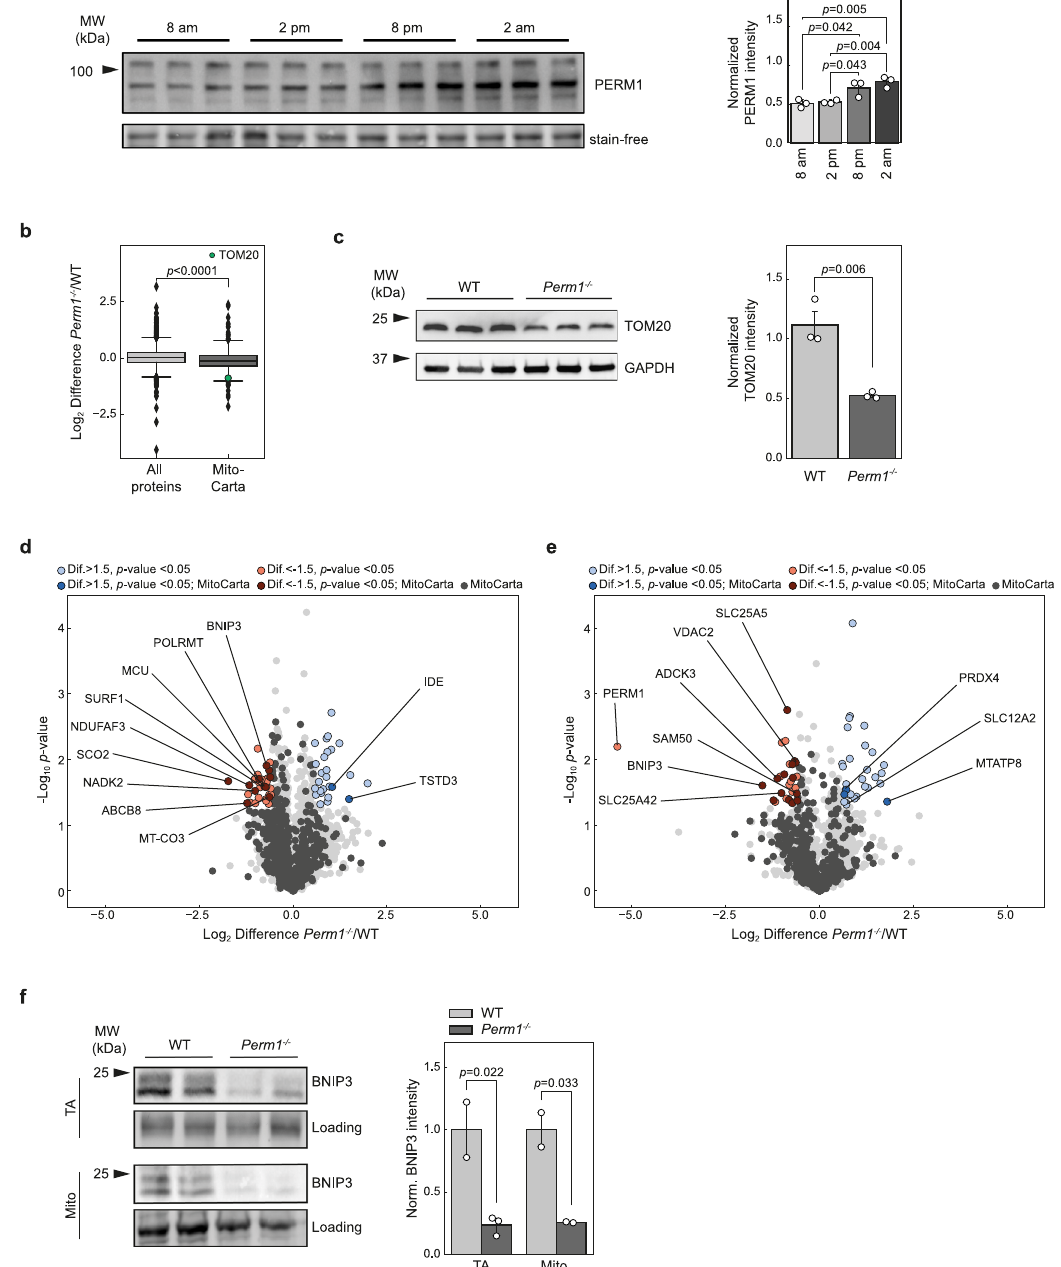
Fig. 3 Inactivation of Perm1 affects mitochondrial proteins related to transportation and breakdown of ROS. a Protein levels of PERM1 at different timepoints in TA muscle determined by western blotting. Normalized protein levels are expressed relative to the mean levels of each protein in the stain- free control ( n = 3 mice per time point). b Comparison of the log 2 differences in MitoCarta 2.0 proteins compared to the complete dataset revealed overall downregulation of mitochondrial proteins in TA muscle isolated from Perm1 − / − mice compared to wild-type controls ( n = 2 mice per group). c Western blot and quanti fi cation of TOM20 in Perm1 − / − TA muscle and wild-type controls, substantiating the reduced mitochondrial content ( n = 3 mice per group). d , e Volcano plots depicting signi fi cantly regulated proteins in Perm1 − / − TA muscle ( d ) and isolated TA muscle mitochondria ( e ) at 11 pm compared to wild-type controls ( n = 2 mice per group). Cut-off was de fi ned as p < 0.05 with a fold change >1.5. Darker colors indicate the MitoCarta 2.0 annotations. f Western blot and quanti fi cation, depicting downregulation of BNIP3 in TA muscle and isolated TA muscle mitochondria from Perm1 − / − mice. BNIP3 levels are expressed relative to the mean levels in wild-type control samples ( n = 2 mice per group). Box plot ( b ) represents the median, 25th, and 75th percentiles, maximum and minimum are connected through whiskers. Outliers are de fi ned as Q 1 – 1.8 IQR and Q 3 + 1.8 IQR. a , d , e Unpaired two-sided Student ’ s t test, S 0 = 0.1, ( c ) unpaired two-sided Student ’ s t test, ( b ) unpaired two-sided Mann – Whitney U -test. Source data are provided as Source Data fi le and in Supplementary Data